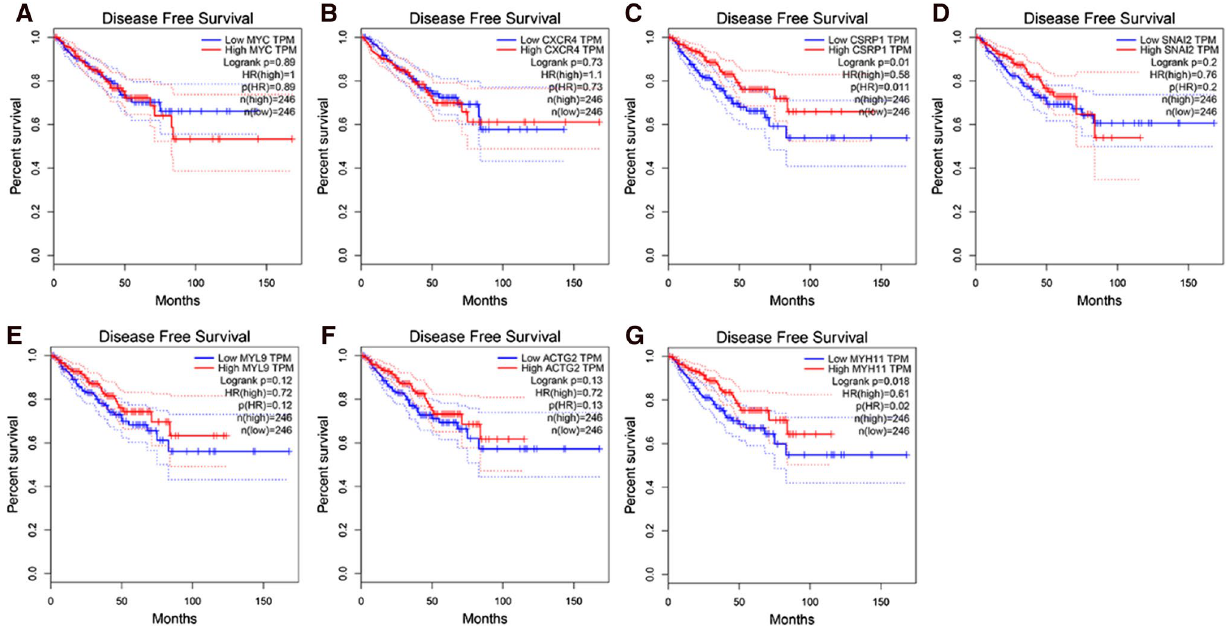
Fig. 7 Survival analysis of hub genes effect in PCa patients’ DFS on TCGA data. A MYC , B CXCR4 , C CSRP1 , D SNAI2 , E MYL9 , F ACTG2 , G MYH11